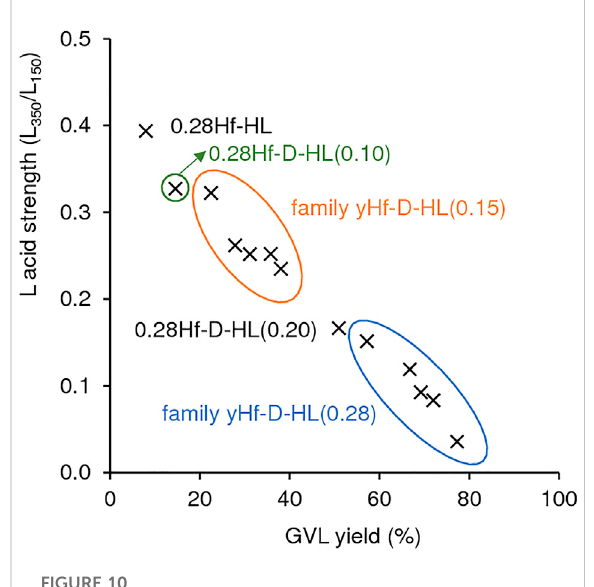
FIGURE 10 In fl uence of the L acid strength (based on the ratio L 350 /L 150 ) onGVL yieldsfortheHf-containingcatalysts. Reaction conditions: